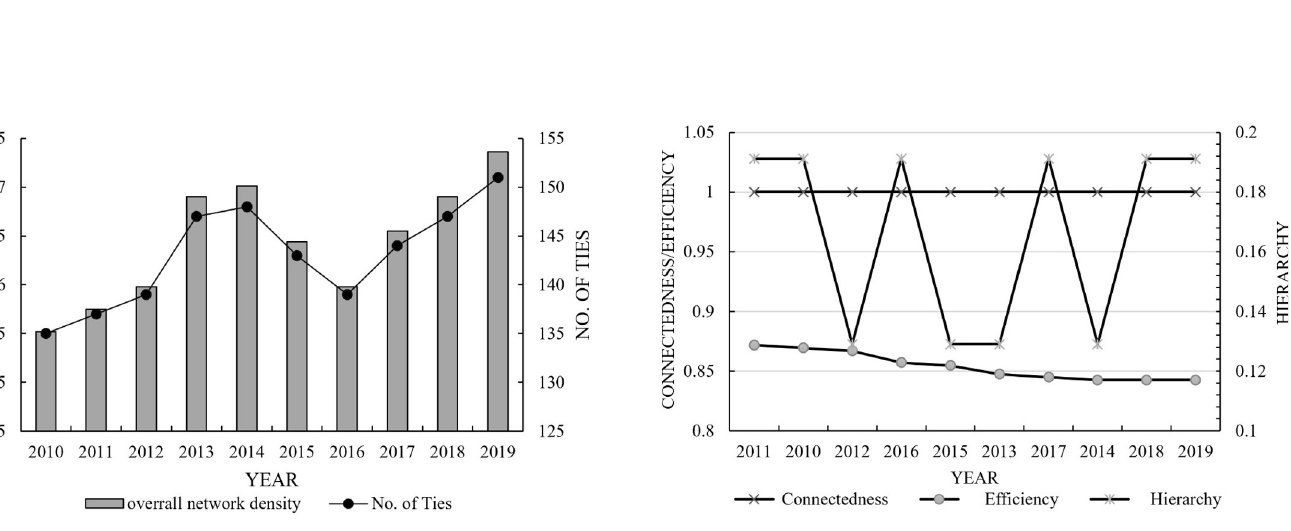
Fig 5. The overall network characteristics of China’s provincial tourism